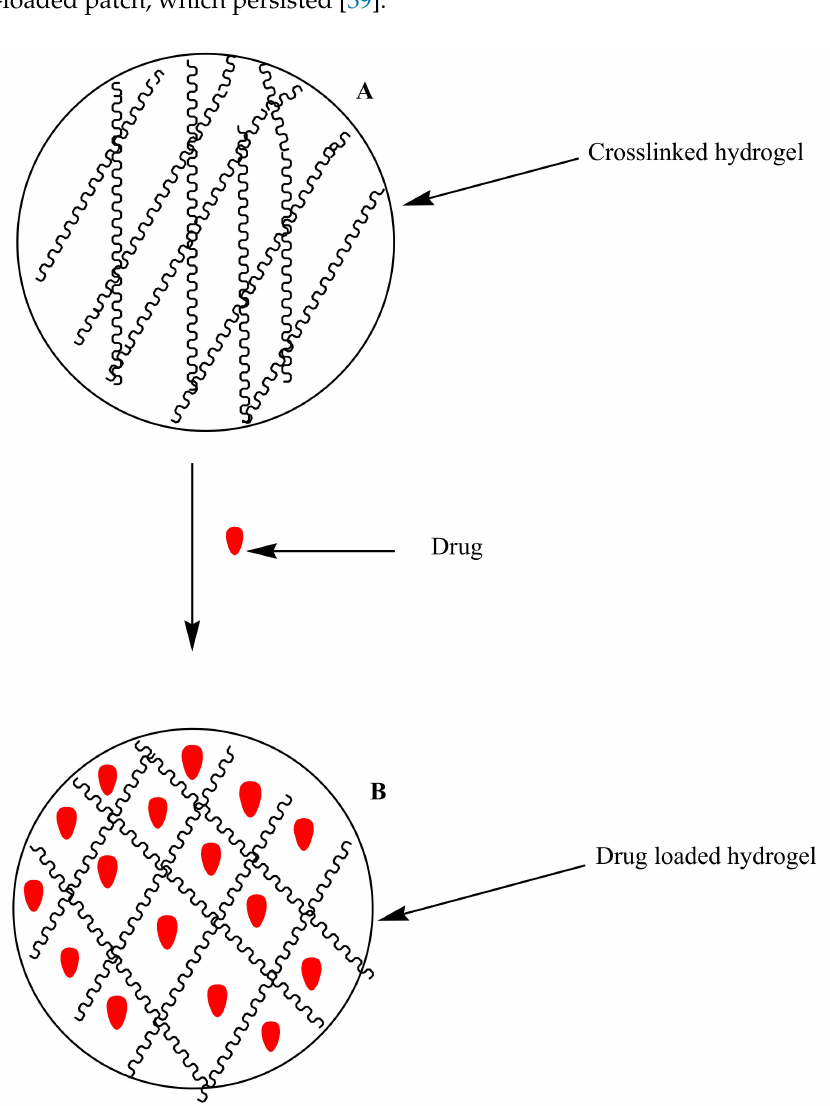
Figure 3. Schematic diagram of: ( A ) cross-linked hydrogel ( B ) Hydrogel encapsulated with